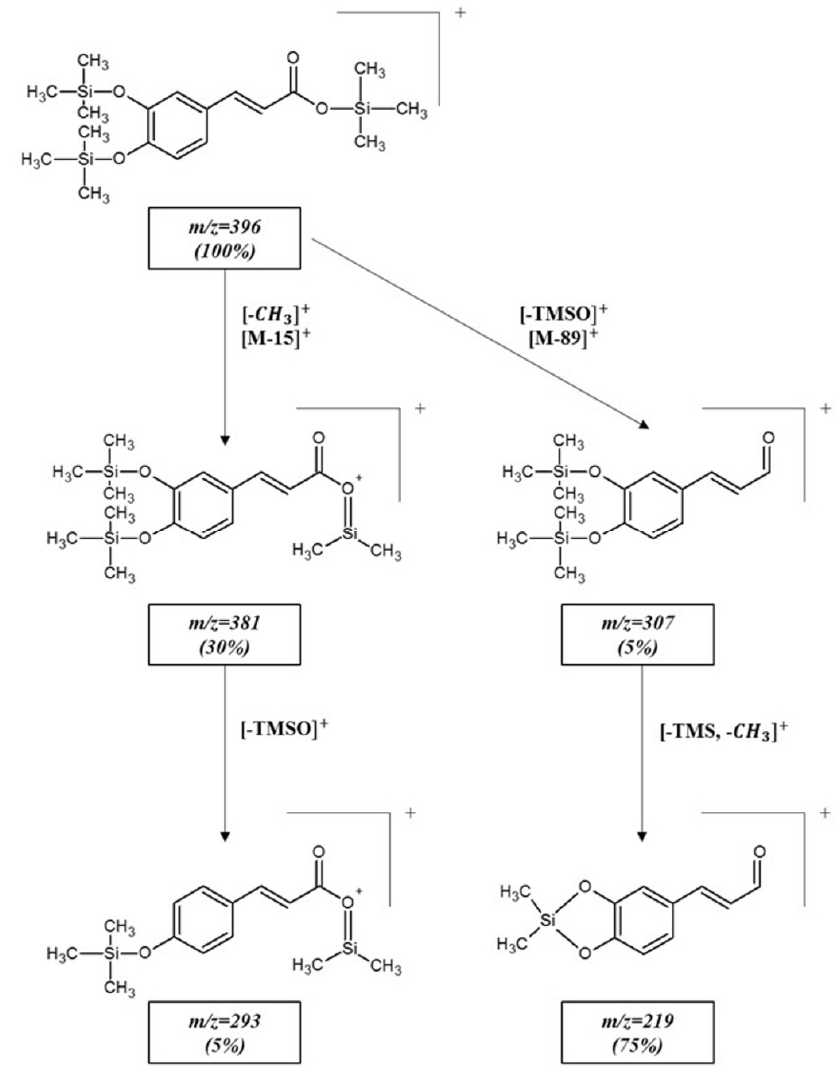
Figure 2. Proposed fragmentation pathway of the trans -CA-3-TMS derivative obtained under positive EI + conditions.